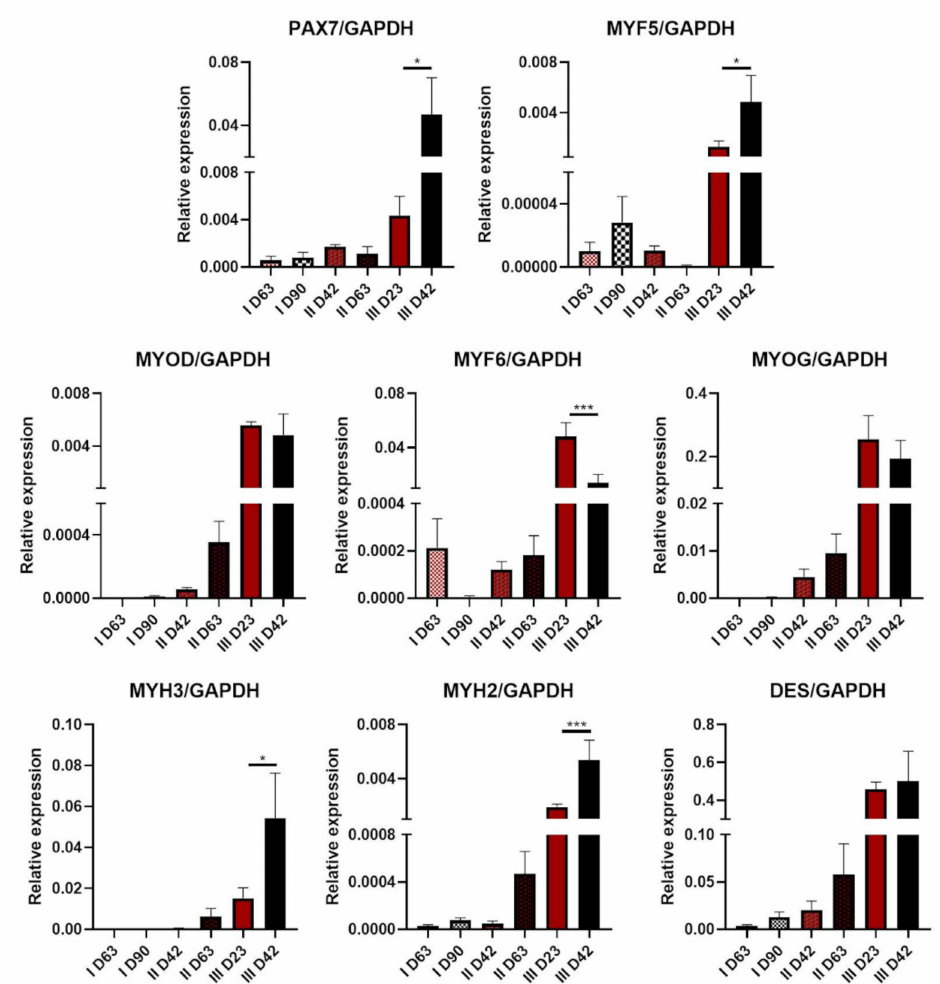
Figure 6. Evaluation of the effects of myogenic protocol extensions: qPCR analysis of myogenic gene expression, n : I = 2, II = 3, III = 3, * p < 0.05, *** p <